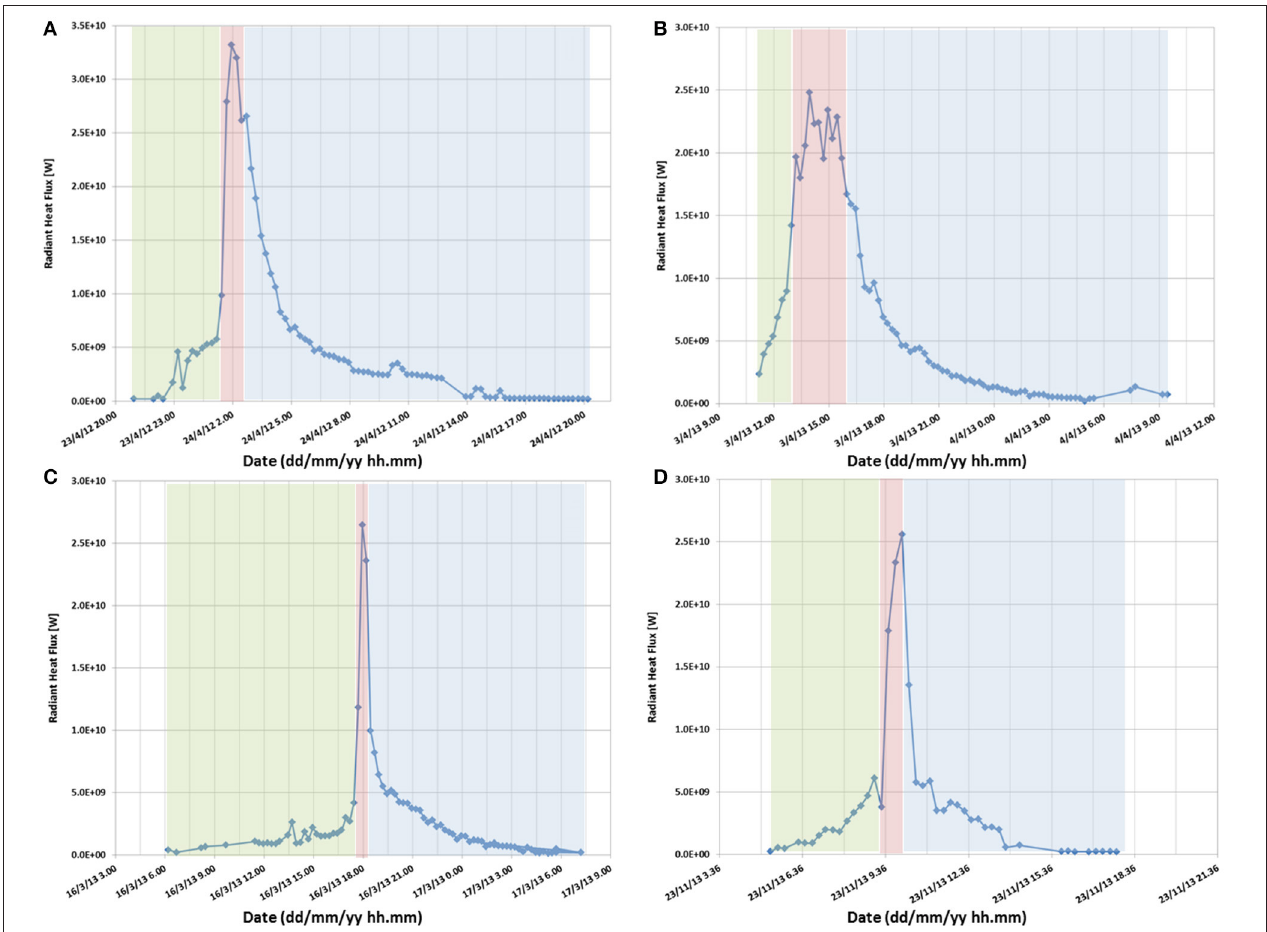
FIGURE 1 | SEVIRI-derived radiant heat flux computed during the 24 April 2012 (A) and 3 April 2013 (B) Etna lava fountains, characterized by the three phases of slow increasing heat flux (green box), main fountaining activity (red box) and cooling (blue box). More peaked radiant heat flux curves computed on 16 March 2013 (C) and 23 November 2013 (D), characterized by a very rapid cooling possibly related to the cooling of pyroclastic material rather than lava.